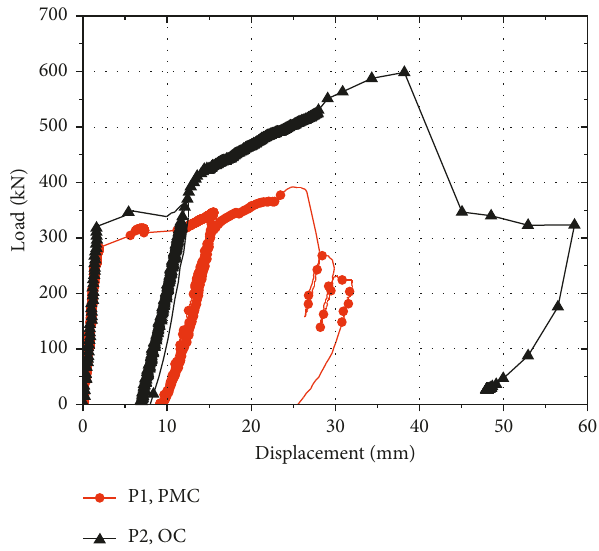
Figure 15: Load-displacement curves of P1 and P2